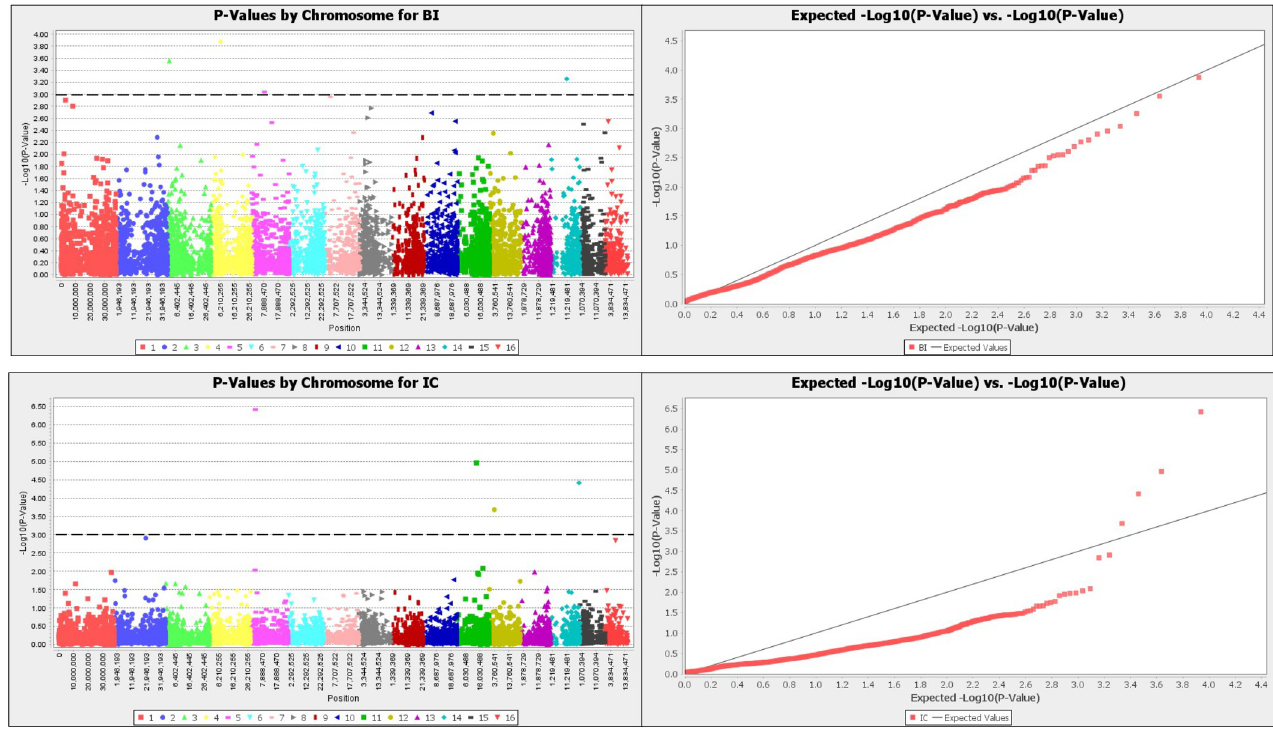
Fig 5. Manhattan plot and QQ plot for branching index (BI), inflorescence color (IC), leaf pigmentation (LP) and leaf shape (LS) of 16 amaranth species.